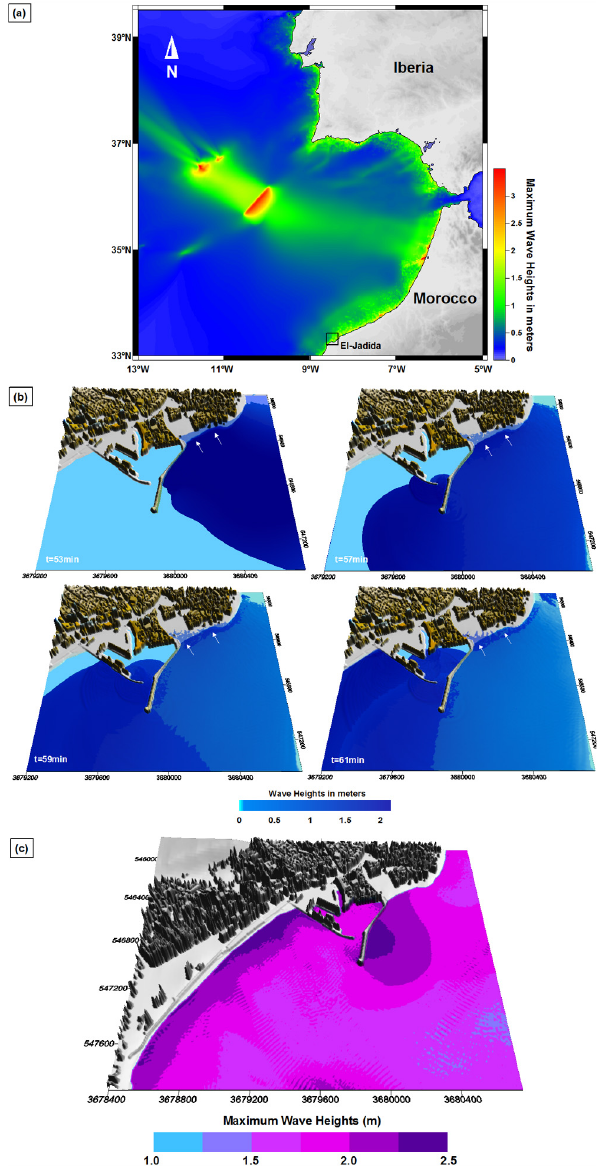
Fig. 5. Tsunami waves’ propagation and near-shore behaviour for the M w = 8 . 0 HS scenario: (a) regional tsunami energy patterns; (b) snapshots of near-shore tsunami propagation at El Jadida site; the white arrows indicate the overtopping locations; (c) maximum wave heights distribution near coasts and the harbour of the studied